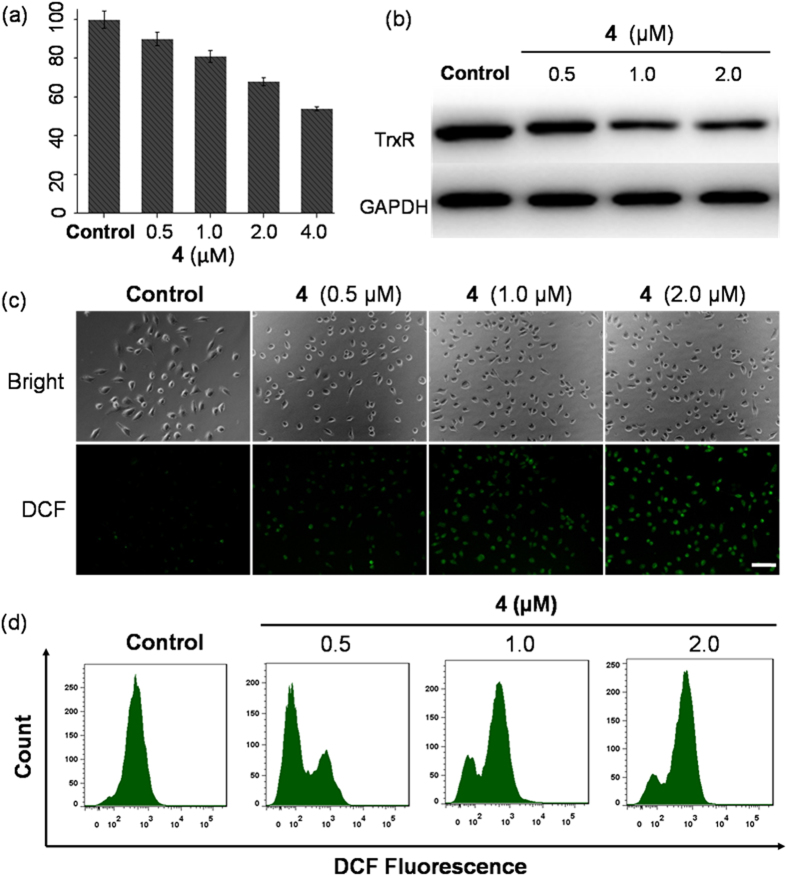
(a) Down-regulation of TrxR activity in A549R cells by complex 4. (b) The expression levels of TrxR in complex 4-treated A549R cells. (c) A549R cells showing an increase in ROS levels when treated with complex 4 under a fluorescence microscope. Scale bar: 100 μm. (d) The intracellular accumulation of ROS was detected by a DCHF-DA assay using flow cytometric analysis.